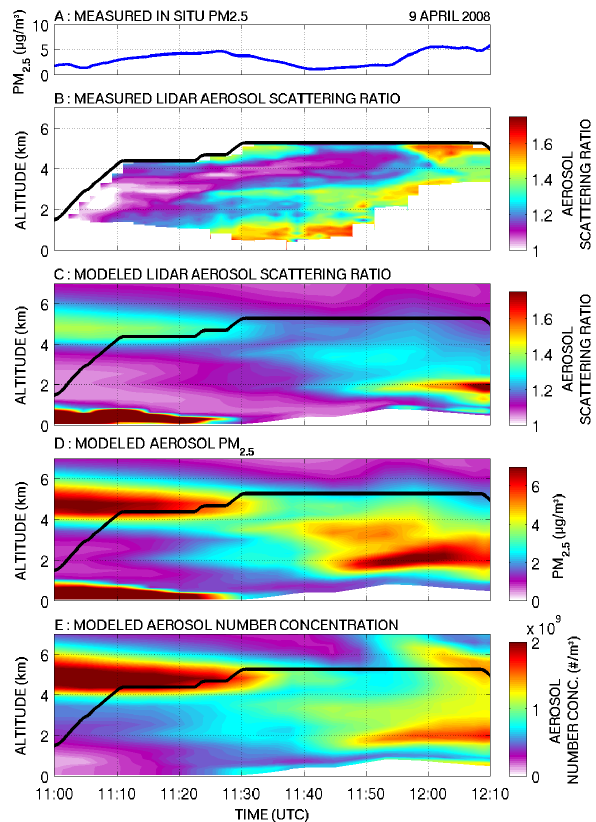
Figure 10. (a) PM 2 . 5 measured in situ during the last part of the 9 April 2008 flight, (b) lidar 532nm pseudo-backscatter ratio mea- sured at nadir during the same portion of the flight (altitude in black, white areas represent topography or cloudy areas where no aerosol data is available), (c) simulated WRF-Chem lidar 532nm pseudo- backscatter ratio, (d) modeled PM 2 . 5 cross section at the same po- sition, and (e) modeled aerosol number concentration cross section at the same position.